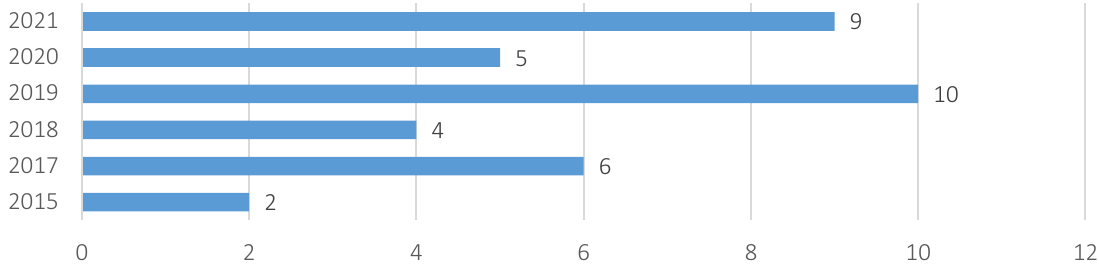
Figure 3. Articles by year of